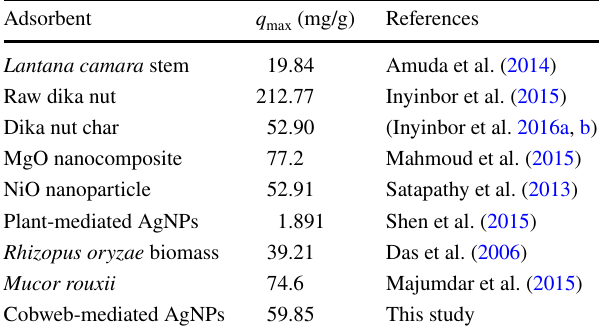
Table 2 Comparison of monolayer adsorption capacity of Rh-B on AgNPs with other adsorbents Adsorbent q max (mg/g)